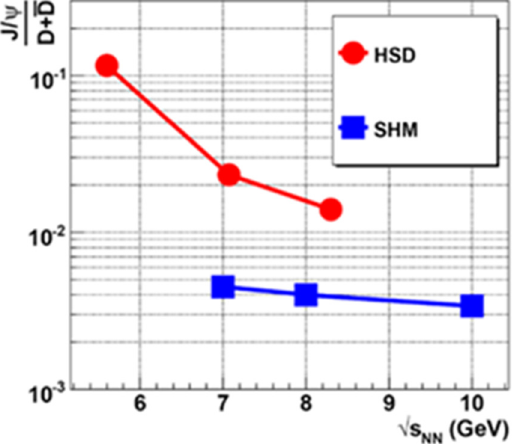
Figure 7. The (J/ ψ )/(D+anti-D) ratio simulated for central Au+Au collisions at different collision energies with SHM (blue symbols) [37] and with the HSD code (red symbols) [38].